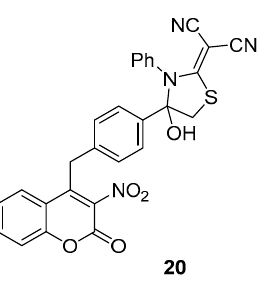
Figure 9. 4-arylamino-3-nitrocoumarin derivative 20 .